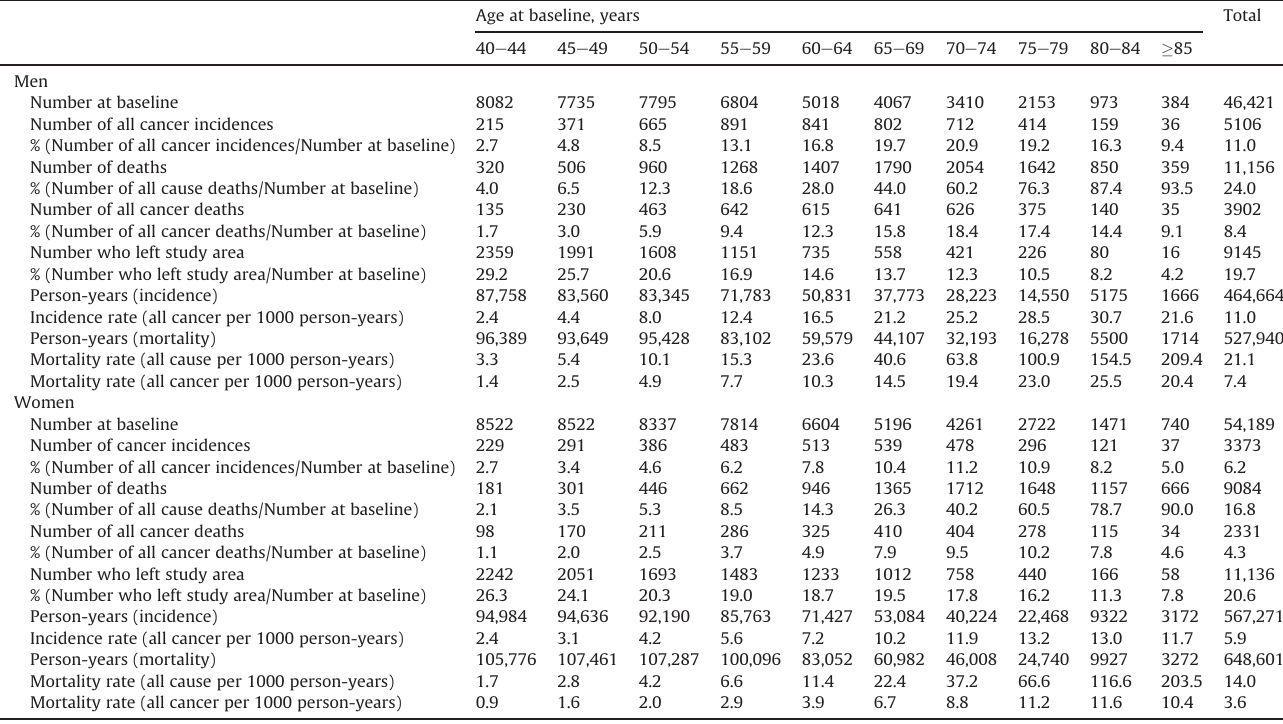
Table 4 15-year follow-up status until 2000 by gender and